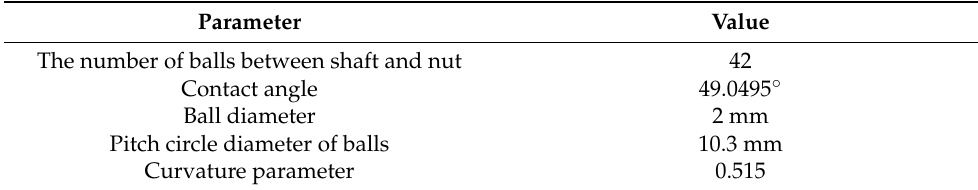
Table 2. Material properties.